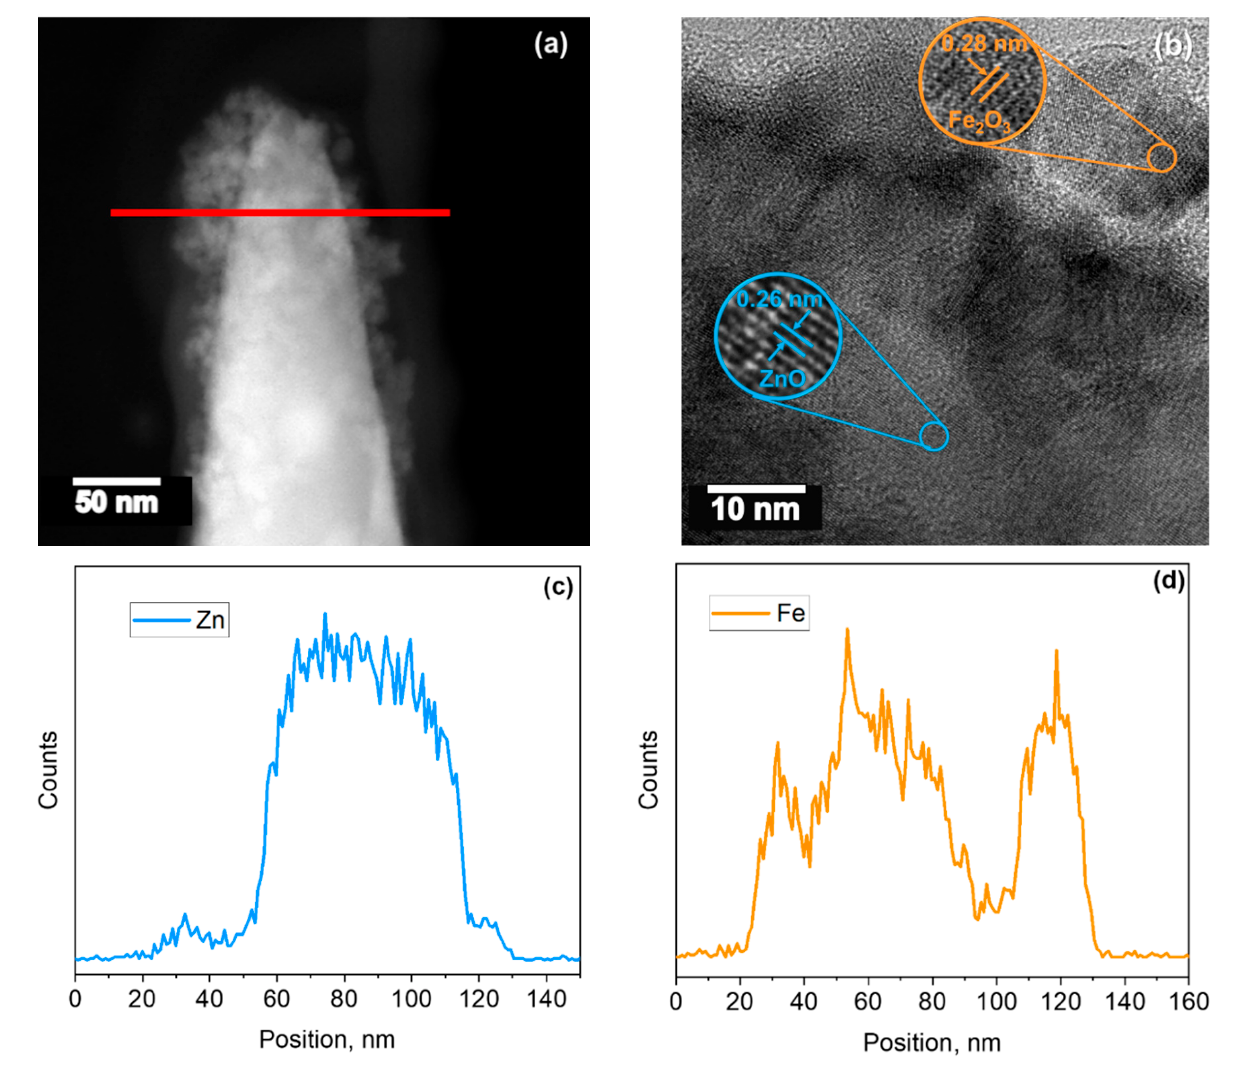
Figure 5. TEM image of a ZnO rod modified with Fe 2 O 3 . ( a ) Low-magnification STEM image, ( b ) high-resolution TEM image, and EDS line-scan profiles corresponding to ( c ) Zn and ( d ) Fe recorded along the red line in ( a ).